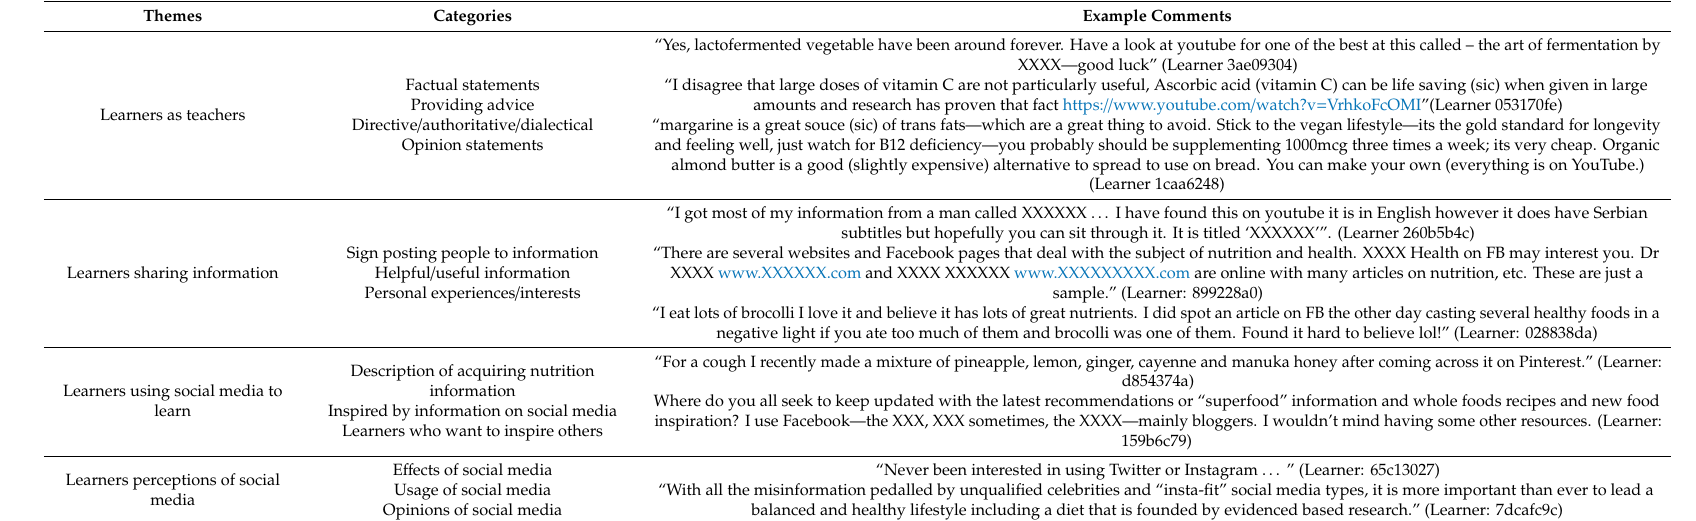
Table A3. Themes and categories of comments referencing social